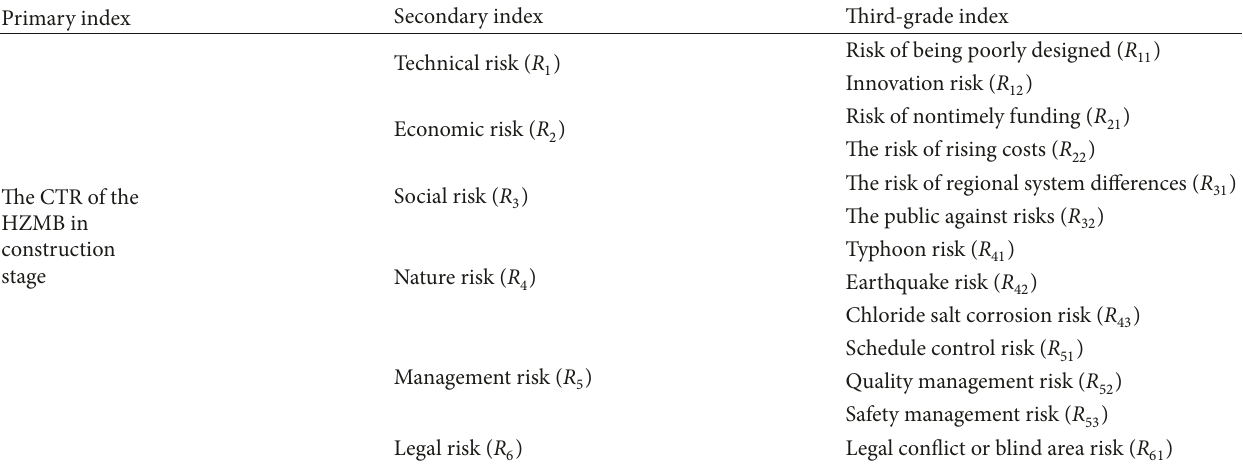
Table 7: Risk evaluation index system in construction stage.